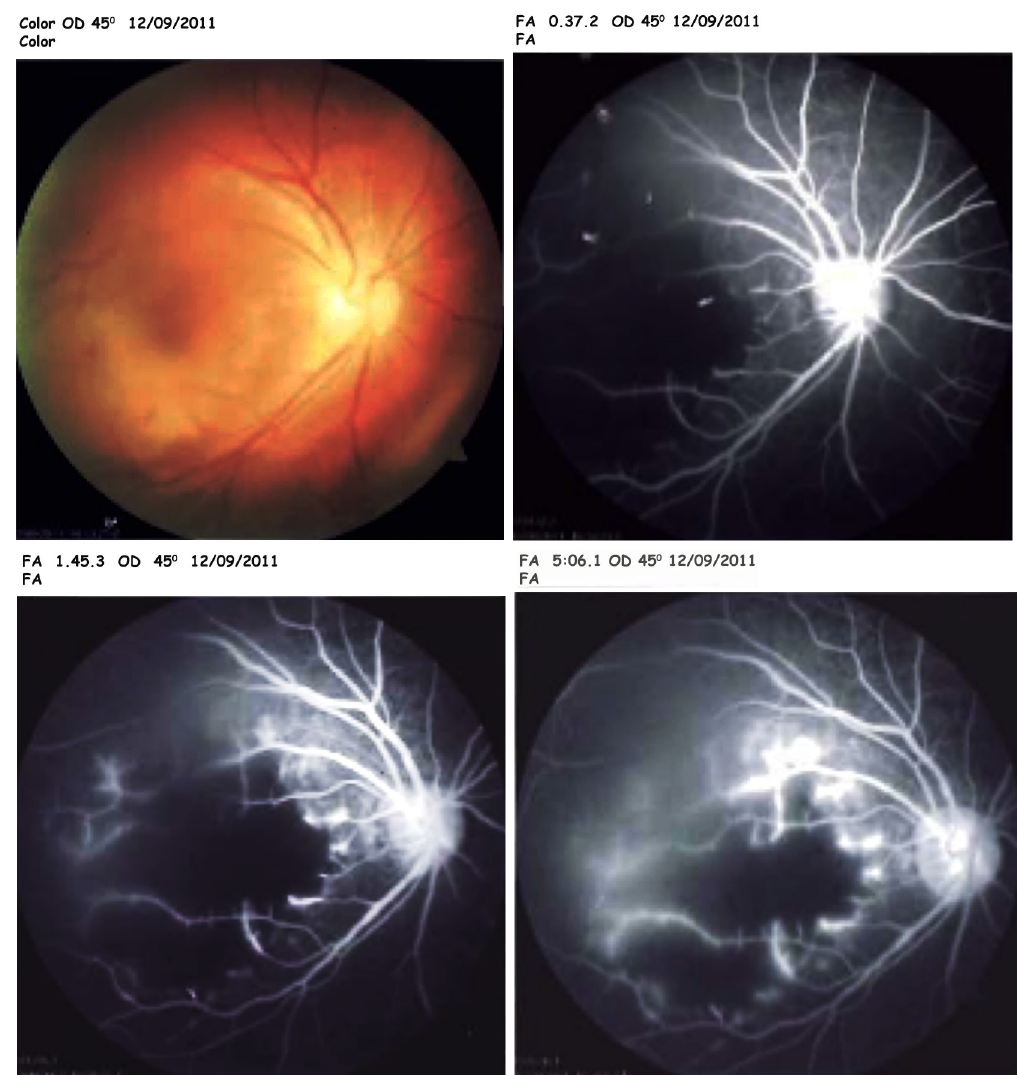
Figure 4: Angiography of the right eye showed macular ischemia